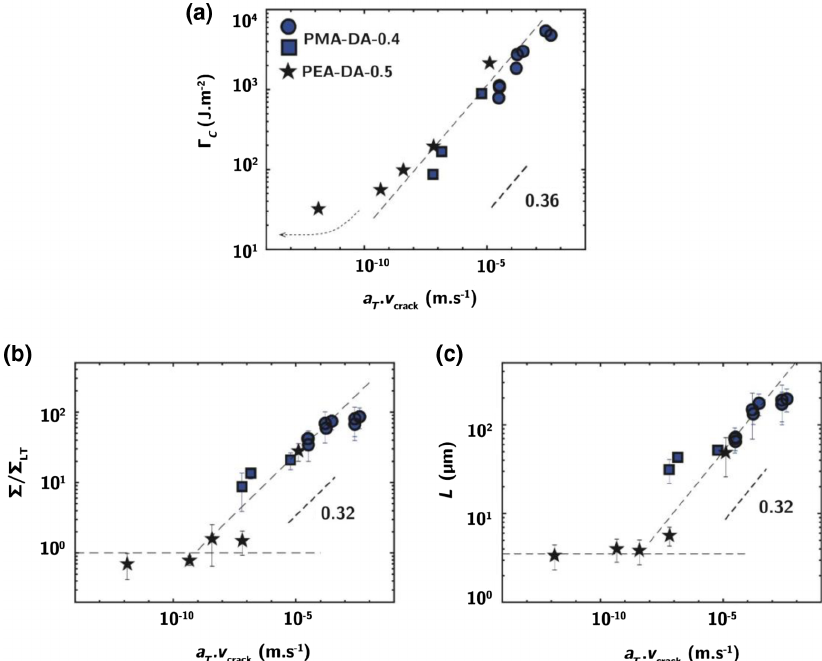
FIG. 4. Coupling of damage with viscoelastic dissipation in the material. (a) Fracture energy Γ as a function of rescaled crack velocity c a :v , for the PMA-DA-0.4 (blue squares and circles) and PEA-DA-0.5 samples (black stars). The reference temperature is taken at T crack 25 °C for the PMA sample (see Fig. S7 [24]). At a low rescaled crack speed, Γ becomes less dependent on crack speed for PEA. The c _ λ ¼ 3 blue square corresponds to samples fractured at stretch rate × 10 − 3 s − 1 and different temperature and blue circles to samples _ λ ¼ ½ 3 fractured at 25 °C and stretch rates × 10 − 4 ; 3 × 10 − 3 ; 3 × 10 − 2 (cid:2) s − 1 . (b) Normalized areal density of broken strands as a function ¼ 1 . (c) Damage length L as a of the rescaled crack velocity. The horizontal line corresponds to the Lake-Thomas prediction Σ = Σ LT function of the rescaled crack velocity. Error bars in (b) and (c) show the standard deviation based on four local confocal measurements on each fractured